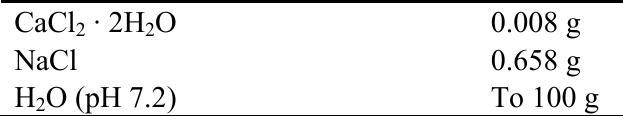
Table 2. Simulated tear fluid composition (receiver solution in transmembrane transport studies)